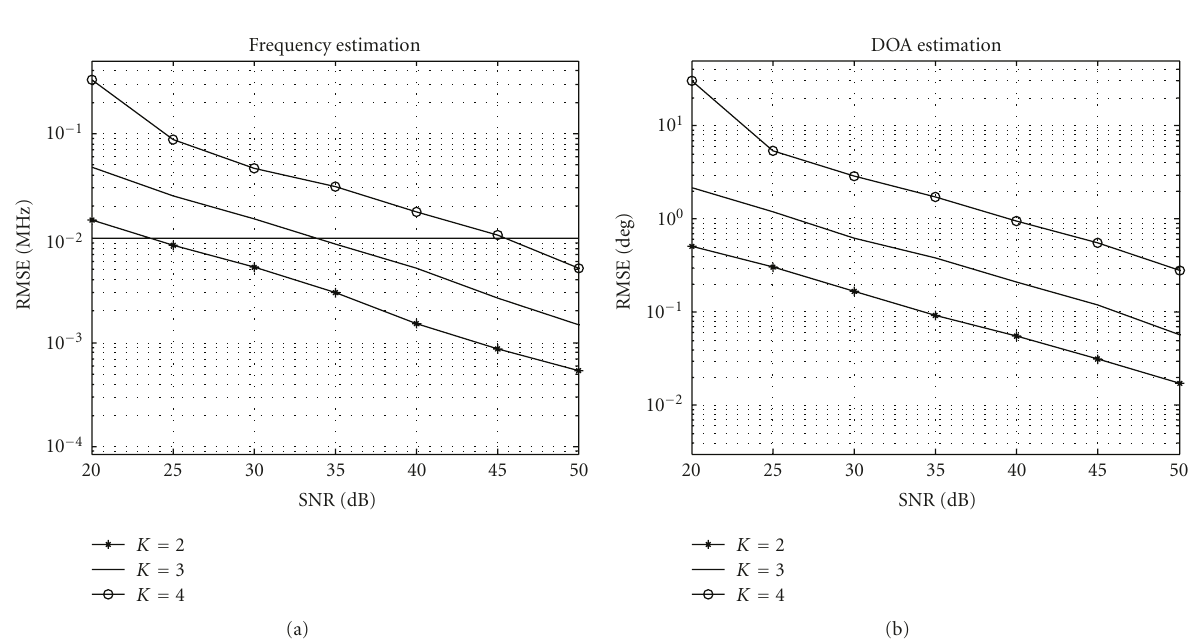
Figure 6: Angle-frequency estimation with di ff erent